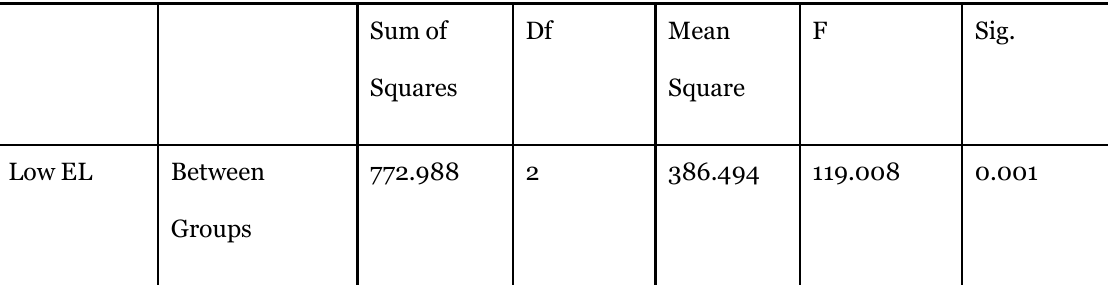
Sum of Df Mean Squares Square